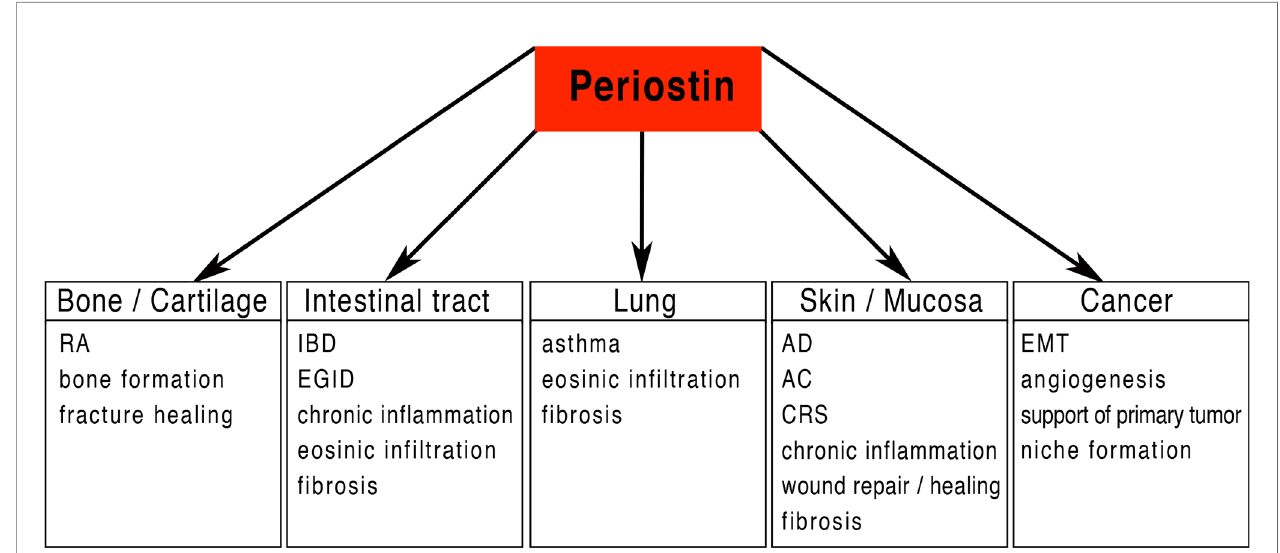
FIGURE 2 | Periostin potential functional implications: Periostin is implicated in a large number of physiological and pathological processes including the attraction and in fi ltration of in fl ammatory cells in a variety of different organs/tissues. Periostin is in a key position for driving chronic in fl ammation and fi brosis in various tissues. RA, Rheumatoid arthritis; IBD, In fl ammatory bowel disease; EGID, Eosinophilic gastrointestinal disorder; AD, Atopic dermatitis; AC, Allergic conjunctivitis; CRS, Chronic Rhinosinusitis; EMT, epithelial-mesenchymal